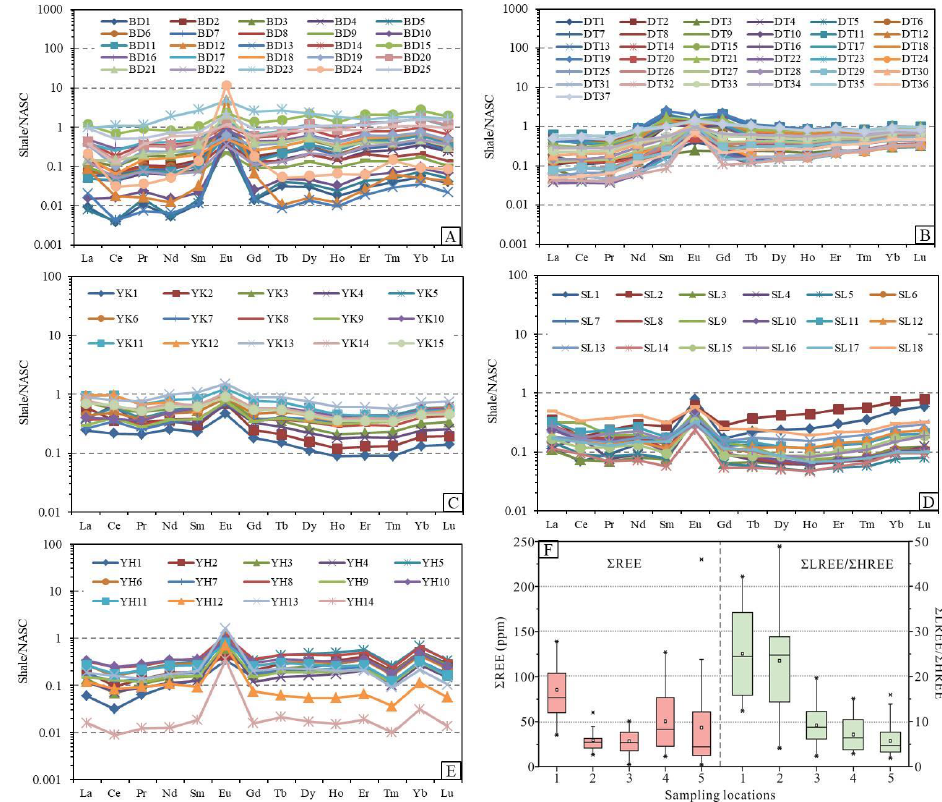
Figure 4. Rare earth element (REE) distribution patterns for the Early Cambrian black shale, and REE contents and light REE to heavy REE (LREE/HREE) ratios. ( A ) ZK205 well, ( B ) ZK102 well, ( C ) Yankong section, ( D ) Songlin section, ( E ) Yonghe section, ( F ) REE contents and light REE to heavy REE (LREE/HREE) ratios (1 — Yankong section, 2 — Songlin section, 3 — Yonghe section, 4 — well ZK102, and 5 — well ZK205. Box-plot: asterisks are the maximum and minimum values, hollow square is average value).